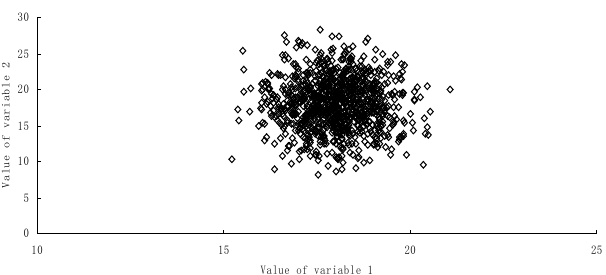
Figure 2. Sampling values of two independent variables with nor- mal distribution.